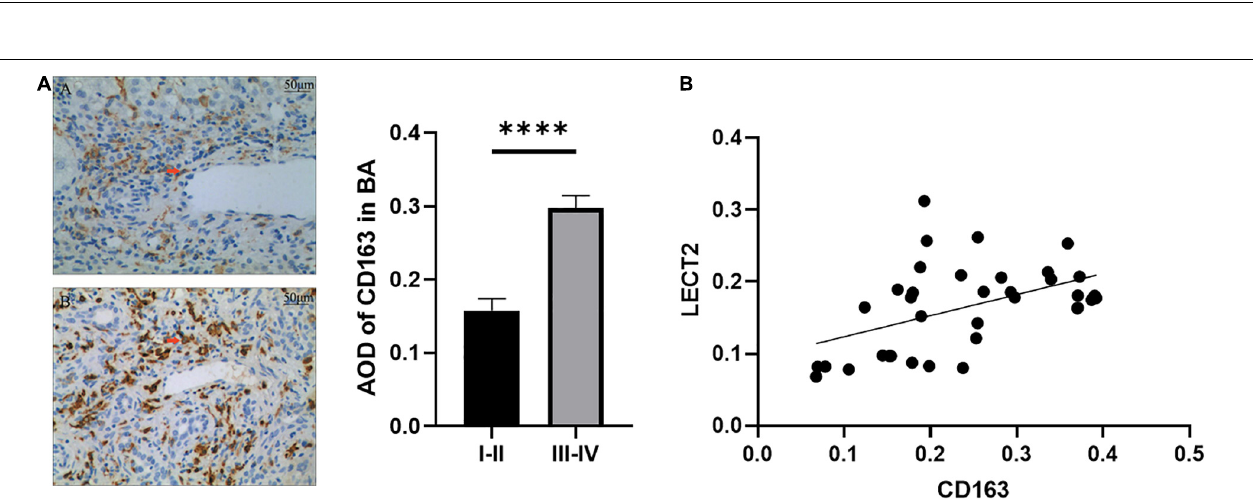
FIGURE 4 | (A) The expression of CD163 by IHC. (B) The relationship between CD163 and LECT2. (A) The expression of CD163 in patients with mild liver fibrosis (A) and patients with severe liver fibrosis (B) of the BA group. The red arrows point to the area of positive expression (200 × ). A stronger AOD of CD163 was observed in patients with severe liver fibrosis than those with mild liver fibrosis through semi-quantitative analysis. (B) LECT2 was positively correlated with CD163. LECT2, leukocyte cell-derived chemotaxin 2; AOD, average optical density; I–II, F1/F2; III–IV, F3/F4. ∗∗∗∗ p < 0.0001.